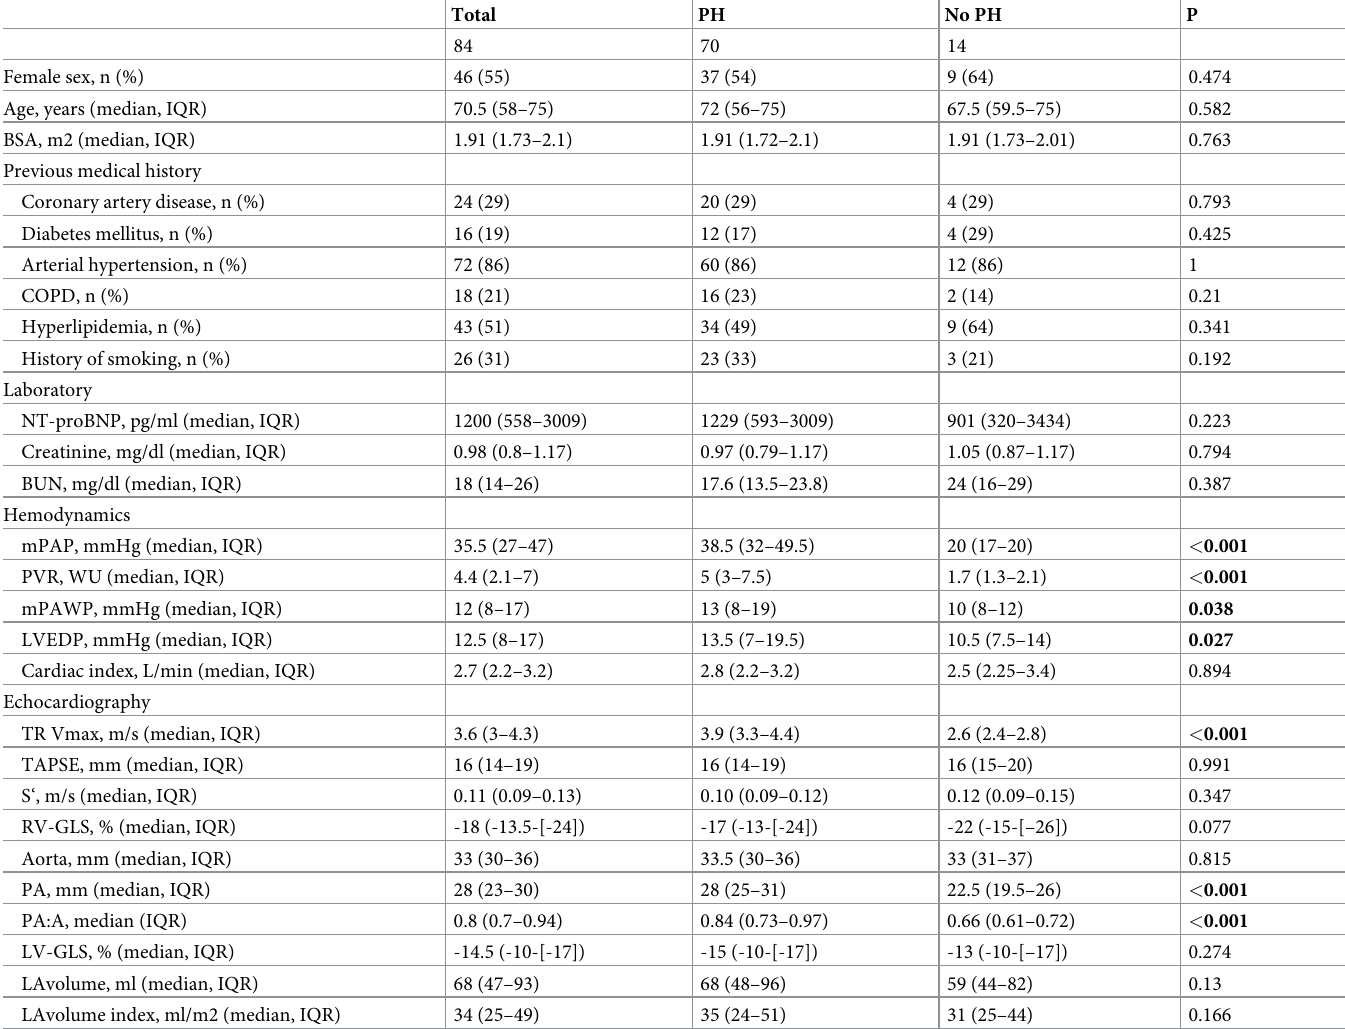
Table 1. Baseline characteristics, hemodynamic and echocardiographic